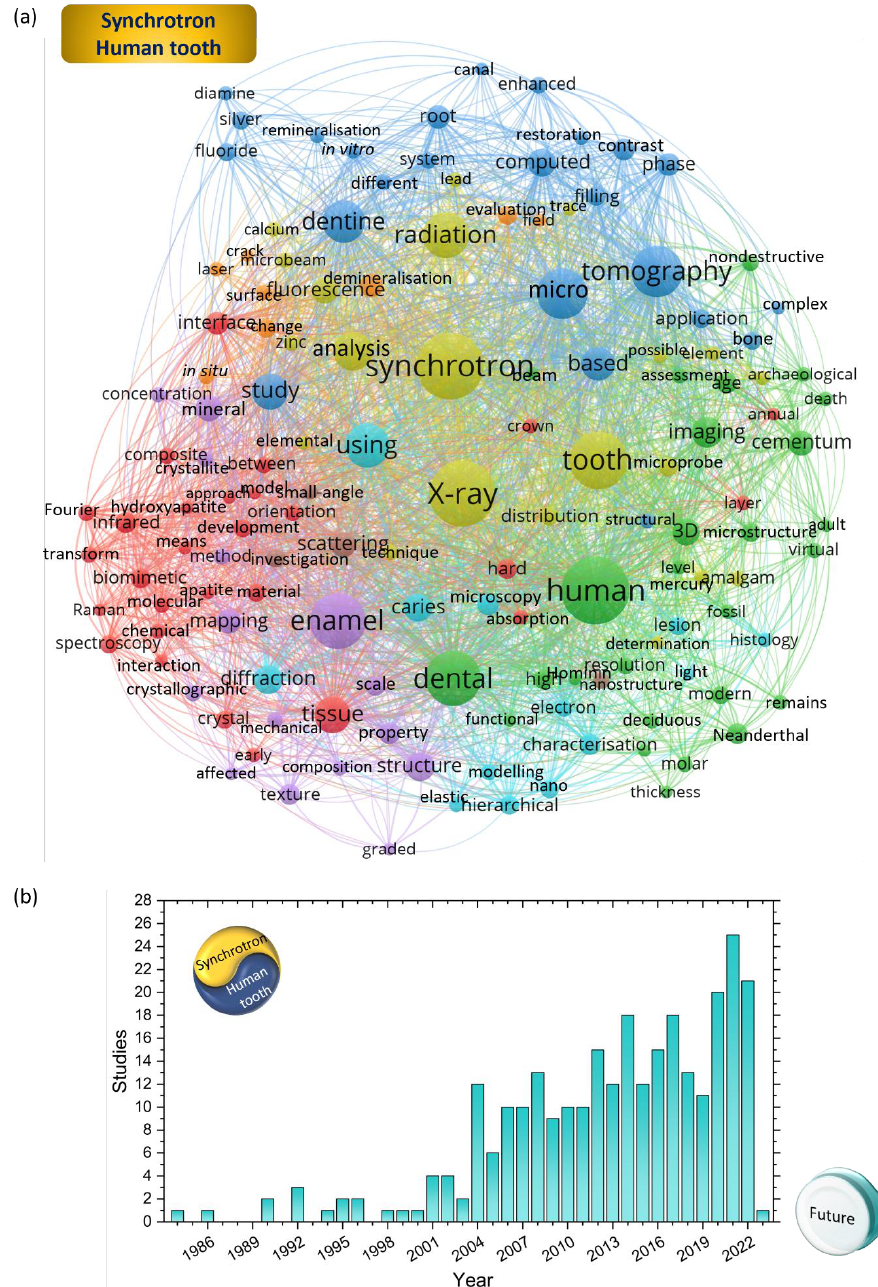
Figure 4. Visualising bibliometric networks of the studies on human teeth using synchrotrons and yearly distribution of the studies. ( a ) Bibliometric network map from studies (human teeth, and in addition, a few studies on archaeological samples e.g., Hominin, and Homo juvenile) from a period of 39 years (1984–2023), from the first report on microradiography in 1984 to a study of 2023. The map was created based on text data and term co-occurrence with the software VOSviewer version 1.6.19 [284]. The data were extracted from Endnote software (Clarivate) in ‘.txt’ format and manually edited to match the reading format and correlation of words; for example, British spelling was applied when translating non-English titles and acronyms were generally written in full length. The minimum number of occurrences of a term was set to four, and in total 140 terms were used based on these studies [11,31,39,56,57,77,78,89,90,121,169–173,175,193,195,247,266,286,294, 299,303–565]. ( b ) Timeline bar chart of the distribution of studies [11,31,39,56,57,77,78,89,90,121,169– 173,175,193,195,247,266,286,294,299,303–565] over the researched